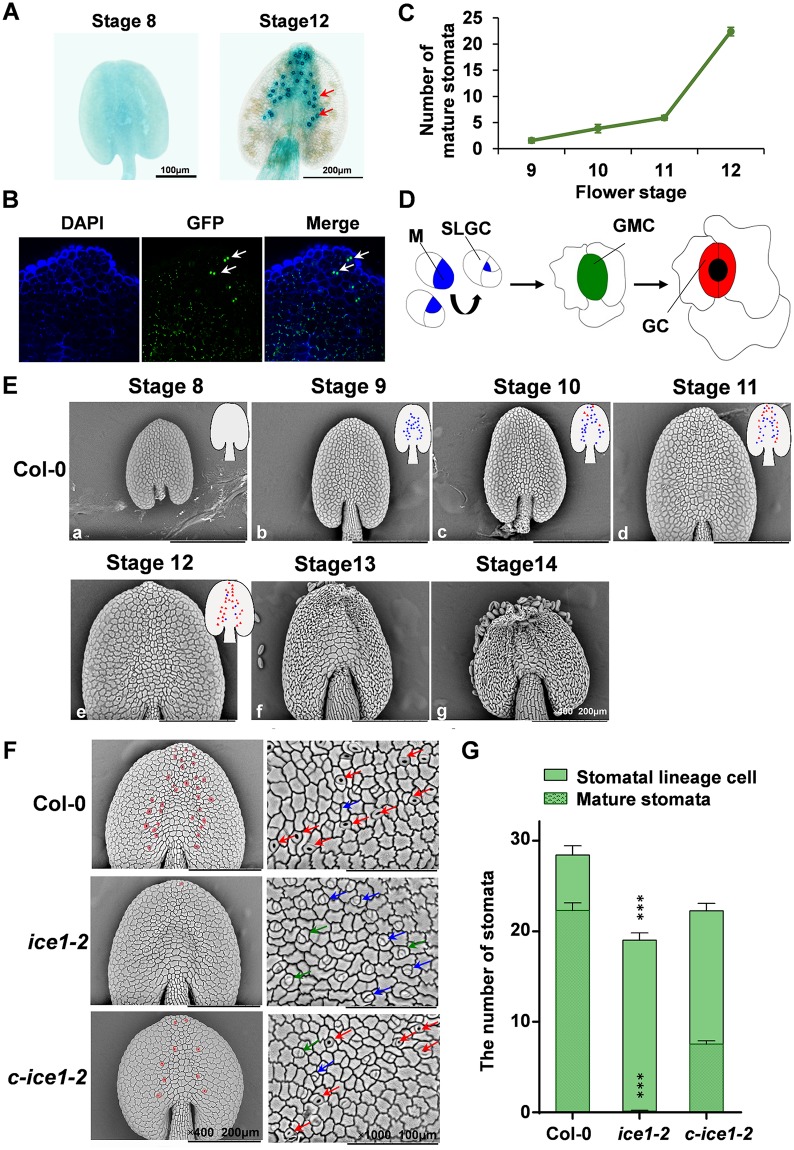
Stomata development of the anther is controlled by ICE1.(A) GUS activity driven by ICE1 promoter is determined in the anther of flower stage 8 and 12. Strong GUS staining is shown in guard cells of stomata in the anther of flower stage 12 (indicated by red arrows). (B) Confocal images showing GFP-ICE1 accumulation (indicated by blue arrows) in the anther of flower stage 12. (C) Stomata numbers of anthers in flower stage 9–12. SE, n = 7–42 anthers. (D) Mode pattern of stomatal development in anthers. Diagram shows cell-state transitional steps within stomatal cell lineages. A subset of protodermal cells (white) assumes meristemoid mother cell (MMC) identity and executes an asymmetric entry division that creates meristemoids (M) (blue) and a sister cell, called stomatal-lineage ground cell (SLGC) (white). The meristemoids reiterate asymmetric amplifying division, but eventually differentiate into the guard mother cell (GMC) (green), which divides symmetrically once to form a stoma with differentiated guard cells (GCs) (red). (E) Scanning electron micrographs of the abaxial side of anthers at flower stage 8–14 in Col-0 (a-g). Anthers increase cell numbers from stage 8 to 9 (a-b). The stomatal lineage cells make their first appearance at about stage 9 (b). The number of stomatal lineage cells increases gradually during flower stage 9–12 (b-e). The majority of mature stomata are formed at about stage 12 (e). Inserts of anthers outline diagram show stomatal lineage cells with blue dots and mature stomata with red triangles. (F) Scanning electron micrographs of the abaxial side of anthers at flower stage 12 from Col-0, ice1-2 and c-ice1-2 plants. Cells colored in pink show distribution of mature stomata. Blue arrows indicate M and SLGC; green arrows indicate GMC; red arrows indicate GC. (G) Comparison of stomata numbers in Col-0, ice1-2 and c-ice1-2 plants at flower stage 12. SE, n = 30–42 anthers, *** p < 0.001).